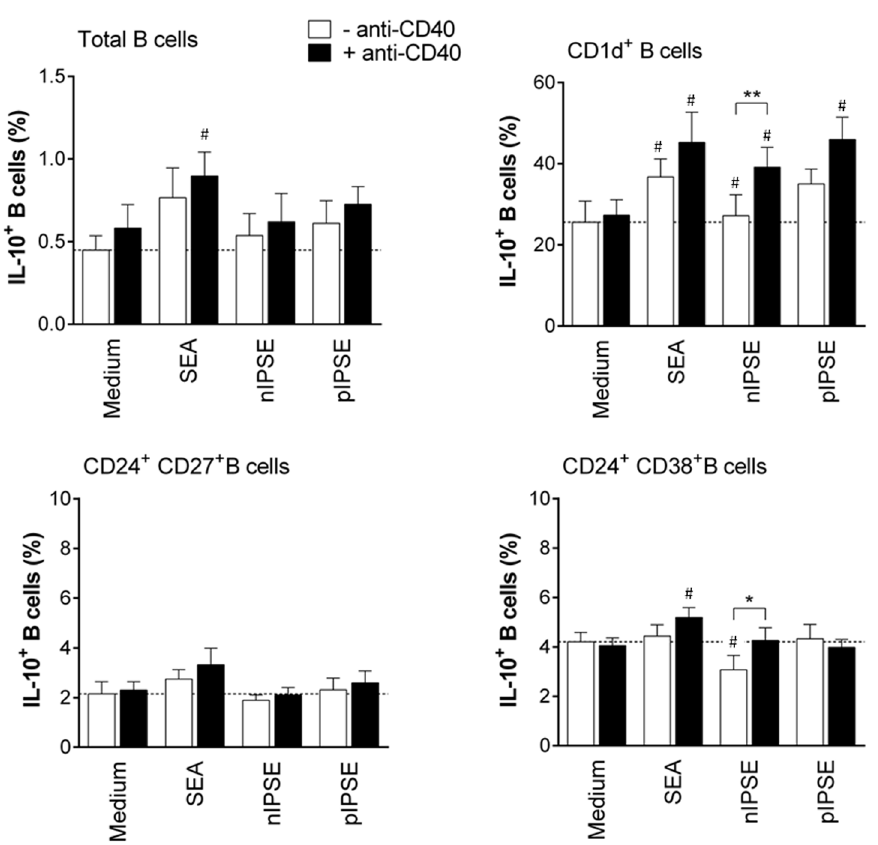
Fig 8. Human CD1d + Breg cells increaseIL-10 expressionafter SEA and IPSE/alpha-1 stimulation. B cells were isolatedfrom PMBCs of healthy volunteers and stimulatedfor 3 days with SEA (20 μ g/ml), natural IPSE (nIPSE, 10 μ g/ml), plant-derived IPSE (pIPSE, 10 μ g/ml), or left untreated. Different Breg cell subsets and intracellular IL-10 expressionwere assessedby FACS. Summary of 3 donors. Significantdifferences to the respective medium control are indicatedwith # p < 0.05, or betweenconditions with and without anti- CD40, with * p < 0.05, ** p < 0.01 as tested by pairedt-test.